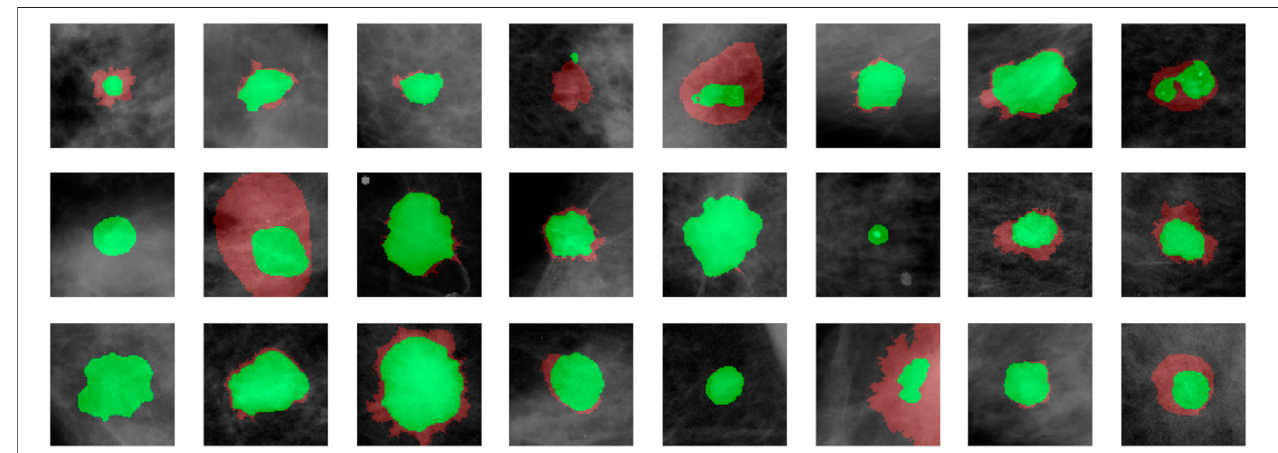
FIGURE 4 | LatentCADx Segmentation. Clinical annotations are denoted in red and LatentCADx segmentations are overlayed in green. The weakly-supervised model constrained with multiple objectives predicted segmentation labels with higher detail than the annotations viewed in training. Predictions are visualized from validation samples which were not observed by the model until evaluation (Mammograms obtained from (Lee et al., 2006); CC BY open access license).